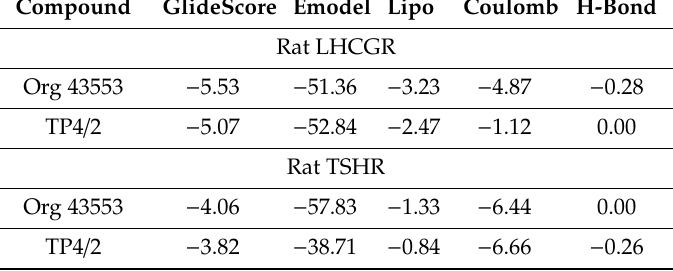
Table 4. The GlideScore, Emodel and Lipo / Coulomb / H-bond values resulting from molecular docking study of the compounds Org 43553 and TP4 / 2 into the transmembrane allosteric sites of rat LHCGR and